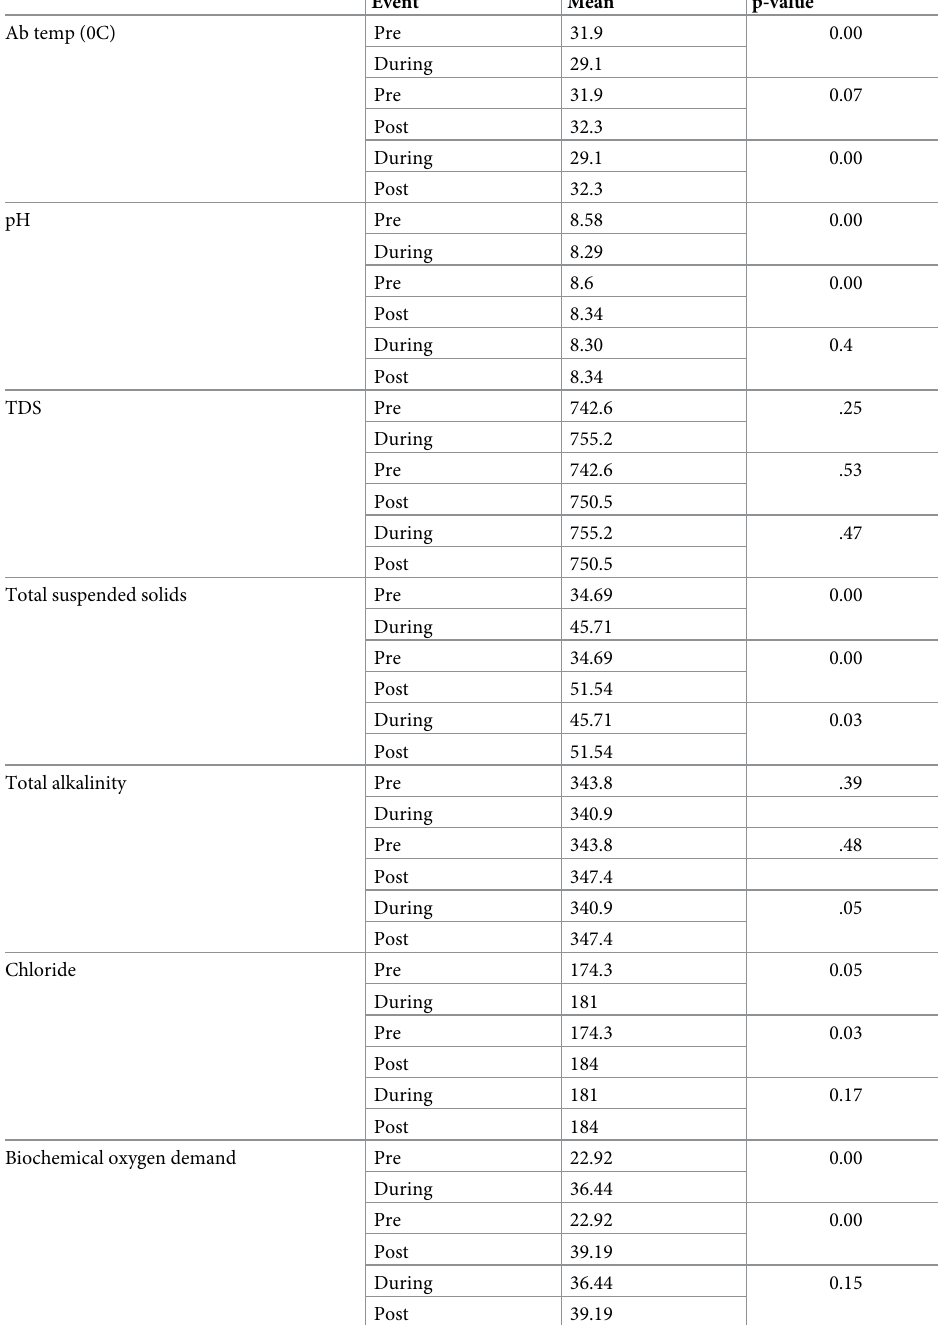
Table 2. Mean value of various physico-chemical parameters of water samples collected at each time points in all mass-bathing events in river Kshipra, Central